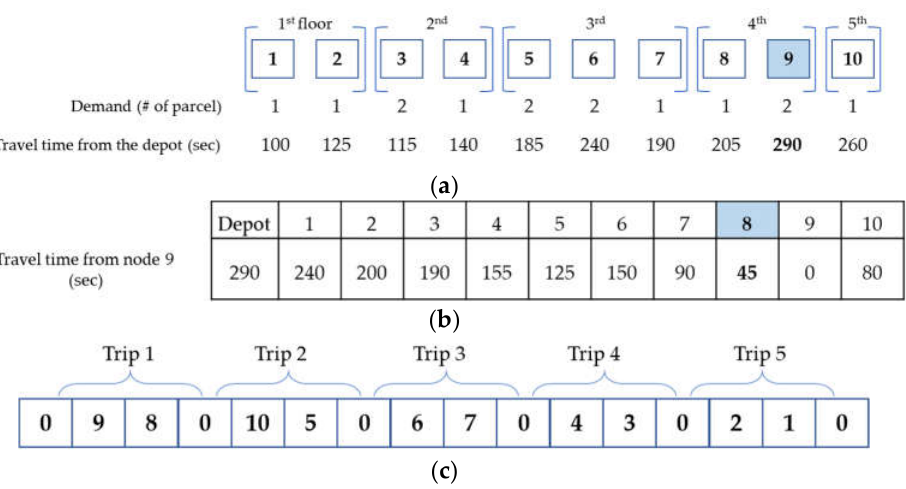
Figure 4. Generating an initial solution by the nearest-neighbor insertion heuristic. ( a ) the travel time from the depot to all nodes is calculated; ( b ) the nearest (closest) neighbor node is chosen; ( c ) the final trips (initial solution) are